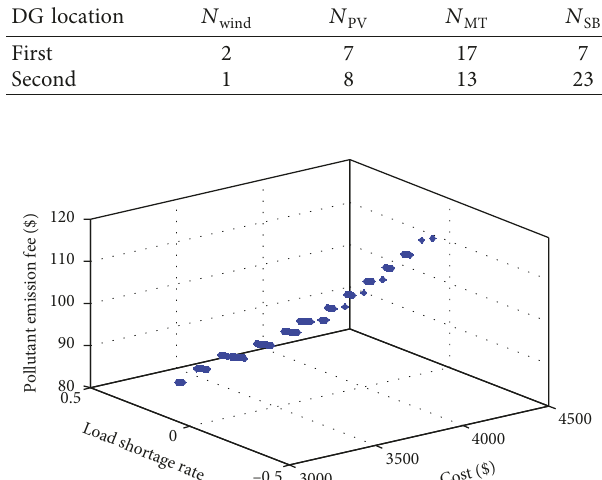
Figure 9: The second Pareto front result.